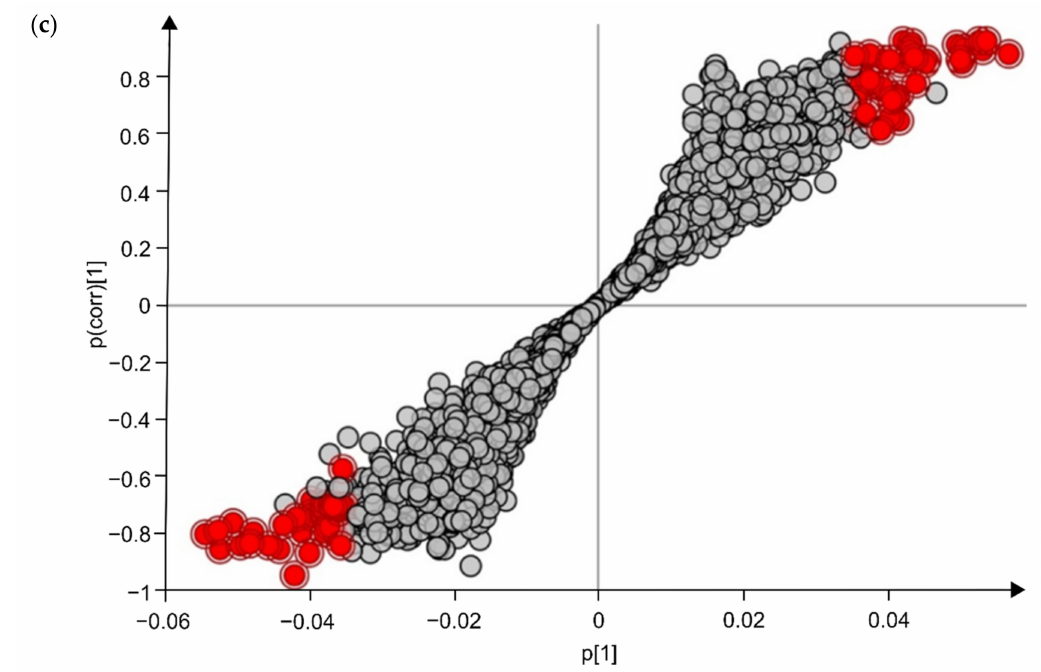
Figure 1. Multivariate statistical analysis plots of LPS challenged calves, for which fecal metabolomics was applied, using the combination of positive and negative ionization modes. ( a ) The PCA-X model’s score plot for the control samples (CON) and LPS challenged calves’ feces samples (LPS, FO, CUR, DEX). ( b ) The PCA-X model’s score plot of LPS day 0 and LPS day 9. The light and dark colors represent days 0 and 9, respectively. ( c ) S-plot for the OPLS-DA model, comparing day 0 and day 9 for the LPS group samples, wherein each dot represents a metabolite. The metabolites ( n = 78) shown in red were retained for further